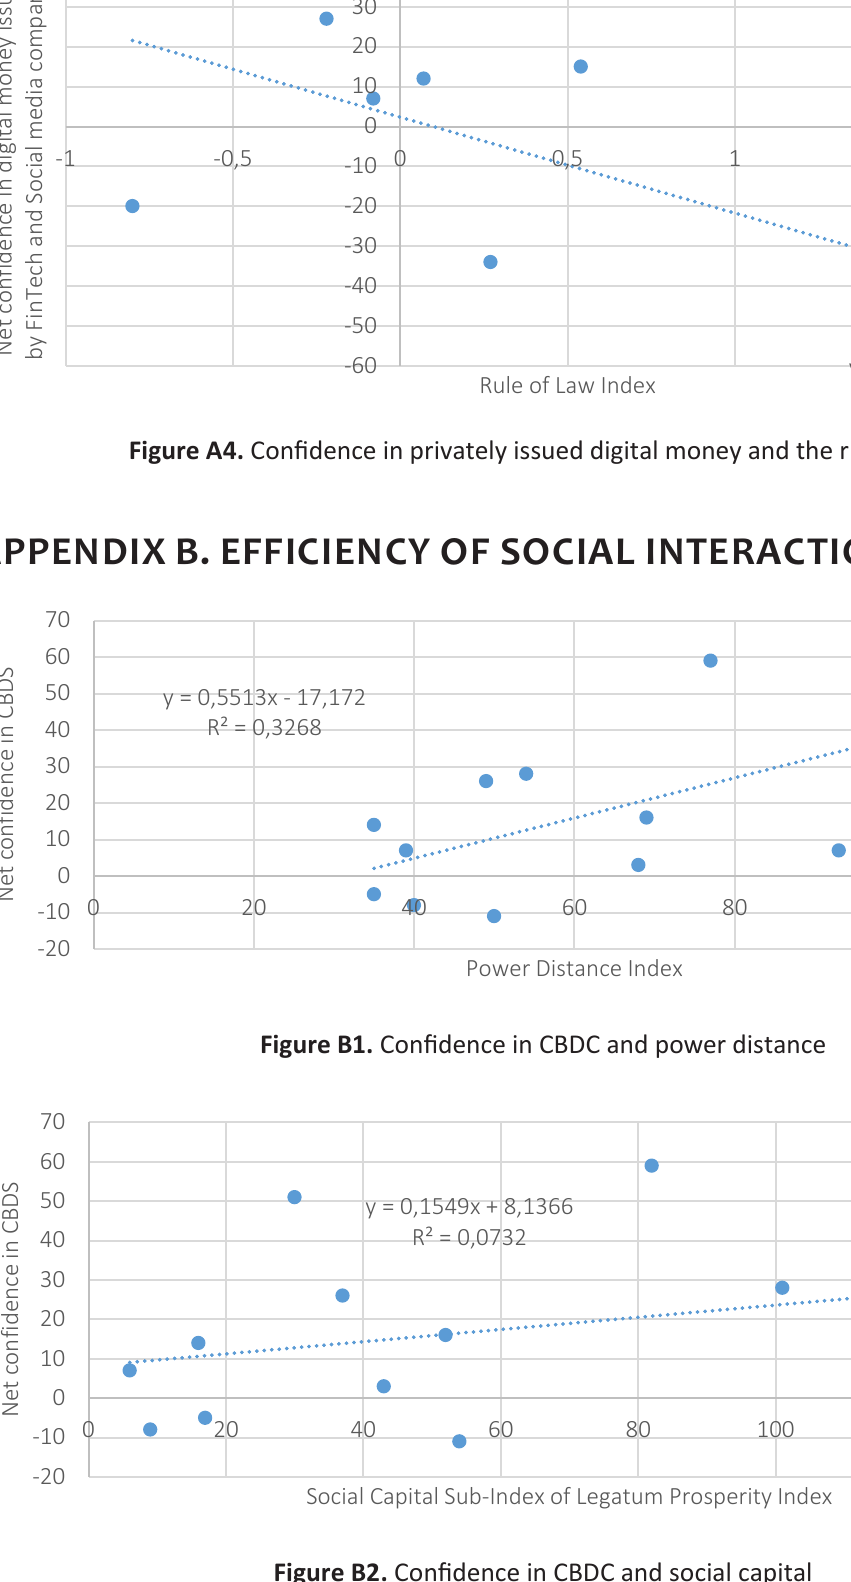
Figure B2. Confidence in CBDC and social